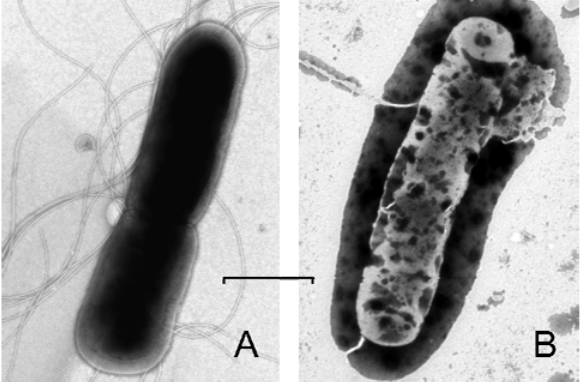
Figure 2. Electron micrographs of negatively stained Bacillus subtilis either untreated ( A ) or treated by lucifensin for 60 min ( B ). Scale bars represent 1